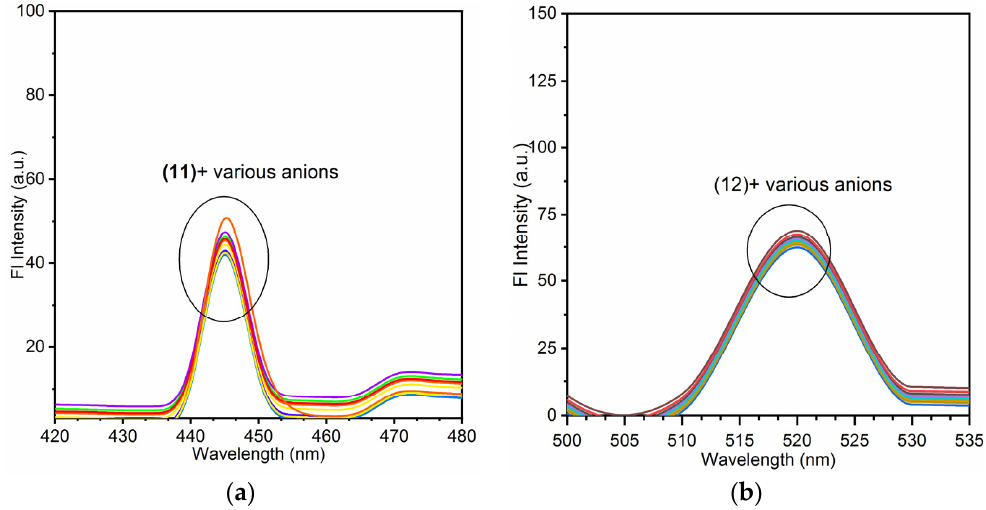
Figure 5. Emission spectra of nano-composites ( a ) → (11) ; ( b ) → (12) in the presence of various anions.